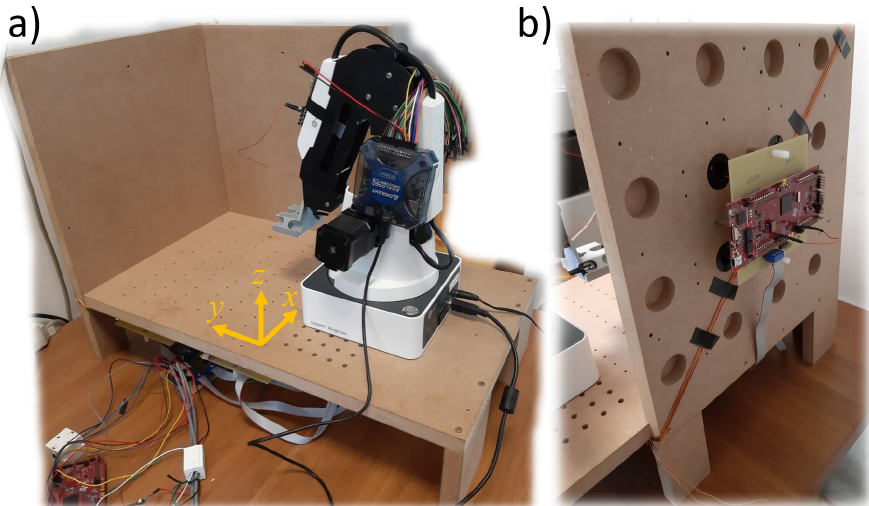
Figure 1. A picture of the system: ( a ) the whole magnetic positioning system with a robotic arm mounted on it. The reference frame is indicated. ( b ) A rear view of the yz plane: the round, carved slots for the receivers are visible; only four receivers are mounted on this plane; signals on the receivers are acquired by a microcontroller unit (the red board in the picture); and the microcontroller is mounted on a custom circuit board (the yellow board) described in Section 2.10. The other four receivers with a microcontroller unit are mounted on the xz plane; sixteen receivers are mounted under the xy plane with four microcontrollers. (The diagonal wire was used to wirelessly power the small solenoid (TX) in a different setup not treated in this